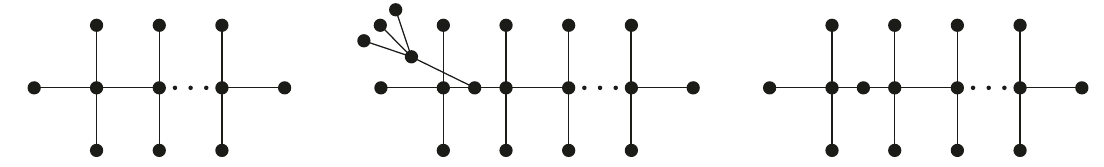
Figure 1: Some examples of the trees belonging to the class T ∗